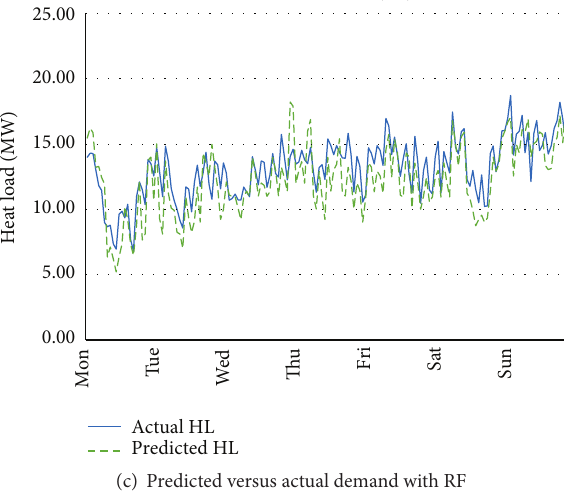
Figure 5: Hourly heat load prediction based on SVR, PLS, and RF for one